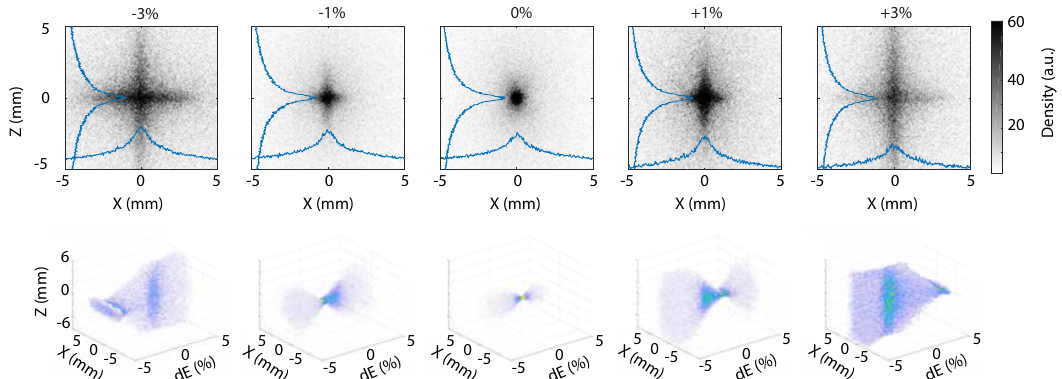
Figure 7. Electron beam transverse shape ( top ) and corresponding vertical–horizontal position per energy ( bottom ) at the undulator exit for the relative gradient change of QUAPEVA 2 of ± 3, ± 1, and 0%. Case of ”undulator entrance” optics with the low divergence beam distribution (Figure 2a and = 2 mrad, σ (cid:48) = 3.12 mrad. Table 1), (cid:101) x , i , (cid:101) z , i =0.2 mm.mrad, σ (cid:48) z , i x , i